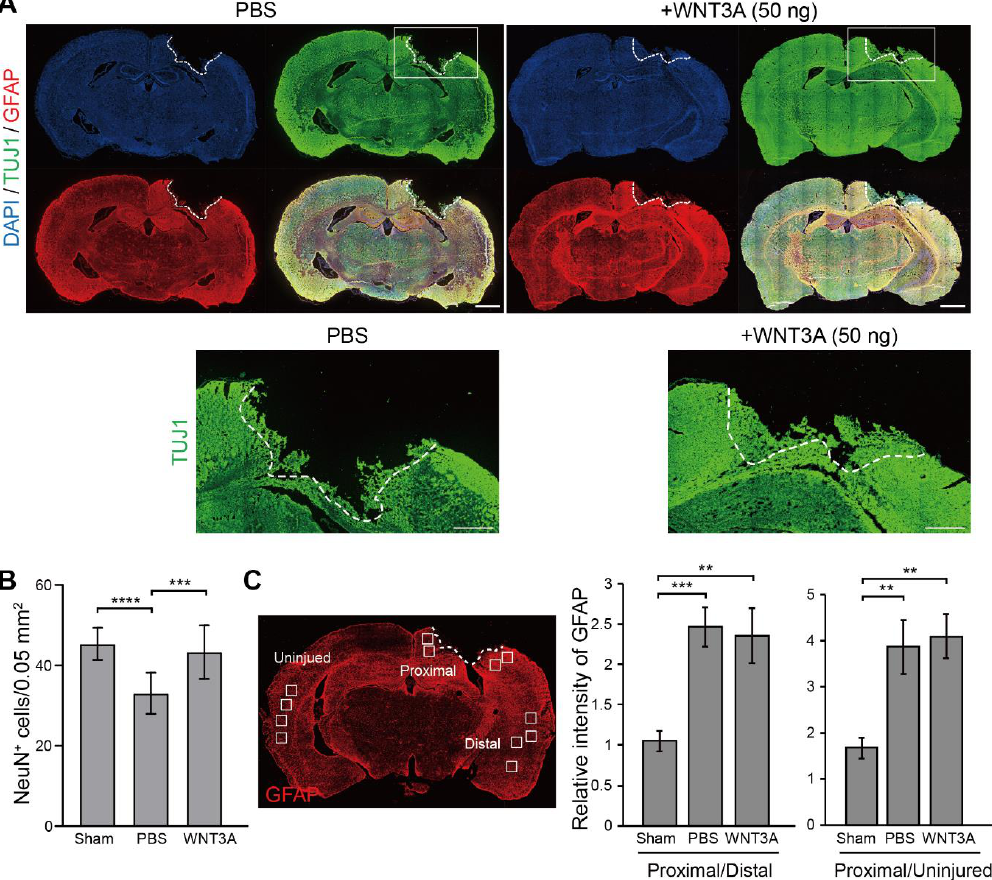
Figure 4. Recombinant WNT3A promotes regeneration of injured brain tissue of controlled cortical impact (CCI) mice. ( A ) The effect of WNT3A on neuronal regeneration was assessed using in vivo CCI mouse model. Cortical impact on motor and somatosensory cortex was generated and the mice were given PBS or 50 ng WNT3A intranasally during 0–3 dpi. Injured brain tissues were fixed, cryosectioned on 4 dpi, and subjected to immunofluorescence staining with anti-TUJ1 (green), anti-GFAP (red) antibodies, and DAPI (blue). White dashed lines depict the border of CCI sites. The regions of interest (ROIs) are indicated in the boxed regions. Scale bar, 1 mm. Enlarged images of the ROIs are shown at the bottom. Scale bar, 0.5 mm. ( B ) The number of NeuN + cells and ( C ) the relative intensity of GFAP of CCI cryosections from sham group ( n = 10), PBS-treated ( n = 12) and WNT3A-treated ( n = 8) CCI animals were quantified as described in the Materials and Methods. GFAP-immunostained cryosection on the left panel in ( C ) defines 0.05 mm 2 -ROIs within white boxes. Dashed lines indicate the borders of the impact site. Data are presented as mean ± SEM. ** p ≤ 0.01, *** p ≤ 0.001, **** p ≤ 0.0001, analyzed by one-way ANOVA followed by Tukey’s test. Functional recovery of damaged motor and somatosensory brain regions was assessed by cylinder test conducted 1 day before injury (−1 dpi), 1, and 3 dpi to quantify the asymmetry use of forelimb (Figure 5A). If the left brain was injured, motor function of the right forelimb would be impaired. A preferred usage of left forelimb (asymmetry use) would be observed. As revealed in Figure 5B, sham-treated mice exhibited 10% variation of asymmetry score from 1–3 dpi compared to that of −1 dpi. PBS administration increased 20%–25% asymmetry score from 1–3 dpi compared to that of −1 dpi, reflecting obvious brain injury. WNT3A administration reduced asymmetry score 10% on 1 dpi and increased 5% on 3 dpi. Together, these functional assays demonstrate that WNT3A administration preserves the motor function of mice upon traumatic brain injury.